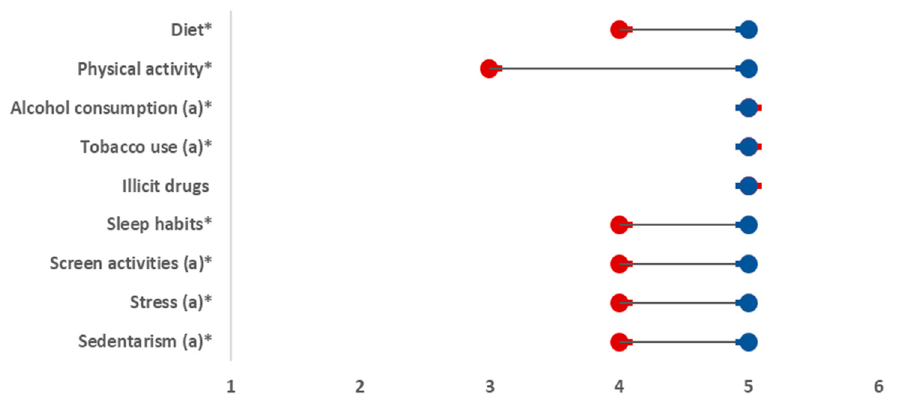
Figure 1. The differences between personal beliefs (dimension 1) and personal behavior self ‐ assessment (dimension 2) for each lifestyle intervention. (*) Significant at 5% (Wilcoxon test with Bonferroni adjustment), p ‐ value < 0.001. (a) Inversion was performed to facilitate the comparison between the variables. Red = median value of personal behavior self-assessment. Blue = median value of personal belief. Note: a higher value is better than a lower value. The only exception existed for the behaviors marked with (a), for which an inversion was carried out to facilitate the comparison.